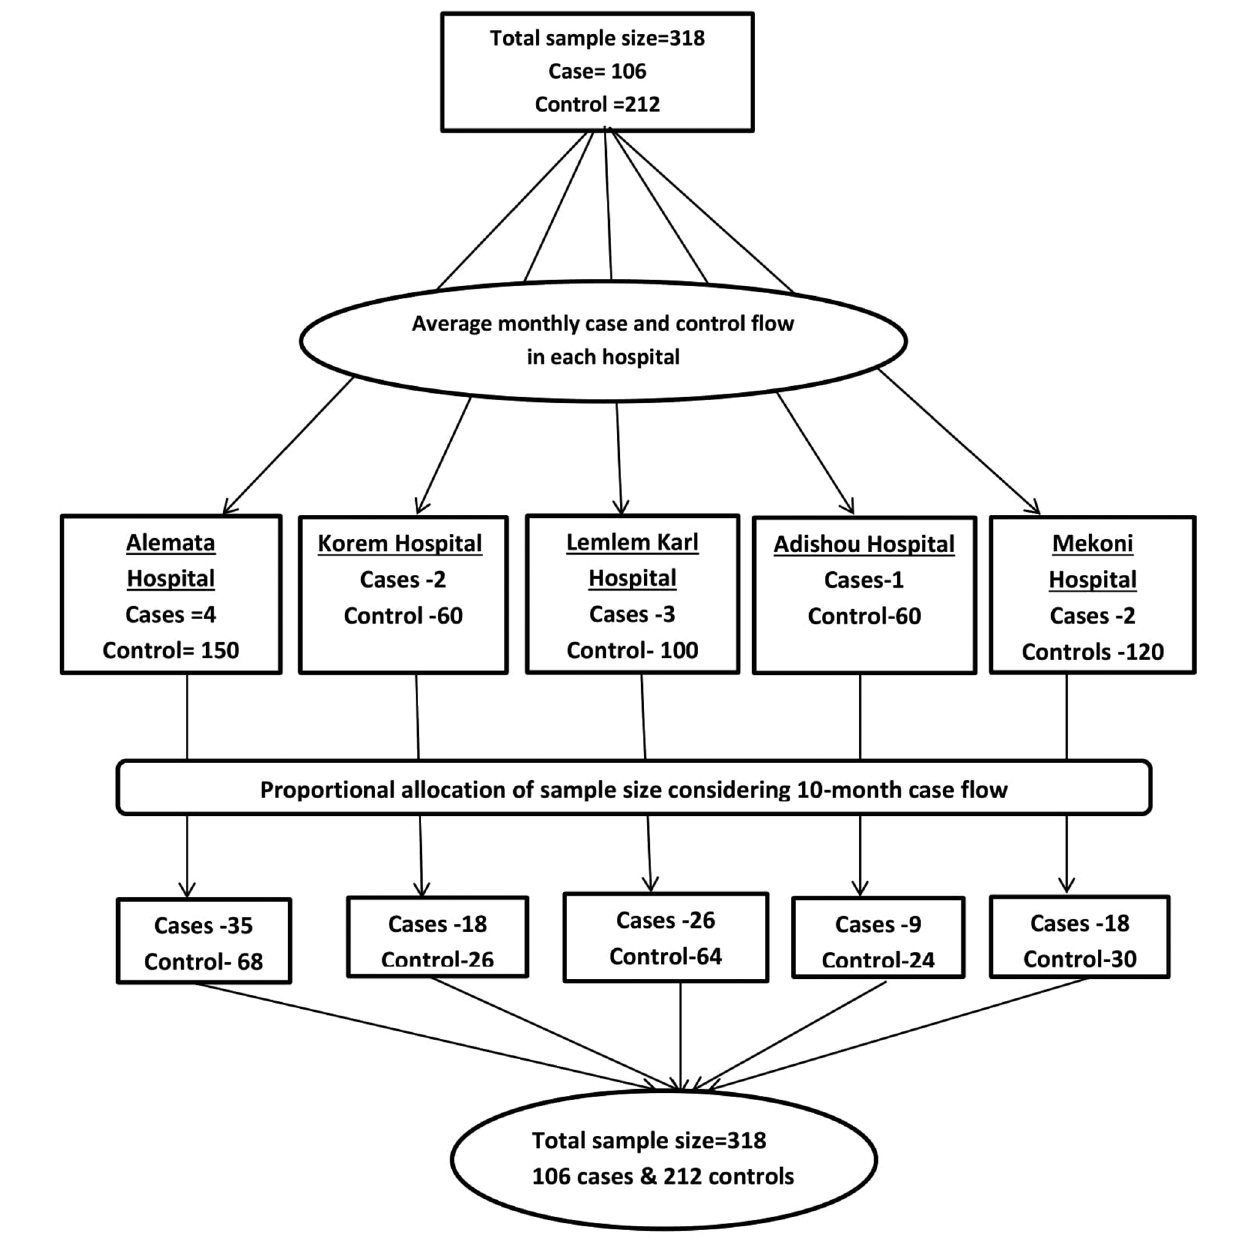
FIGURE 2 Schematic representation of the sampling